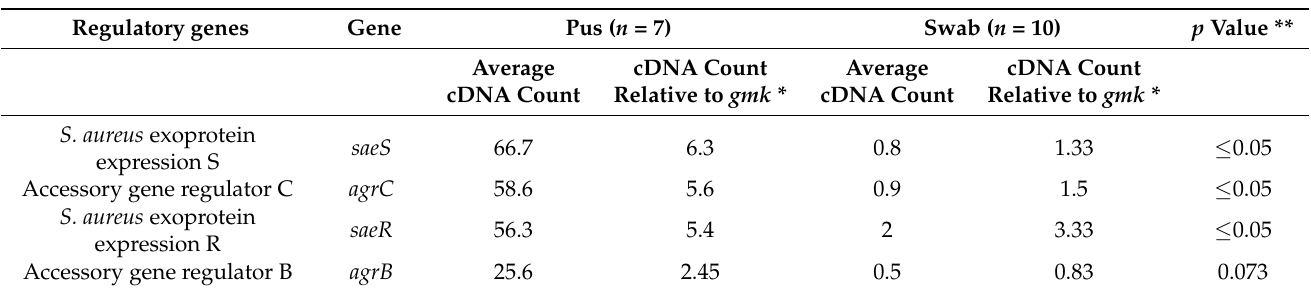
Table 4. The average cDNA count of the regulatory genes from pus or swab samples and their relative cDNA count to that of gmk